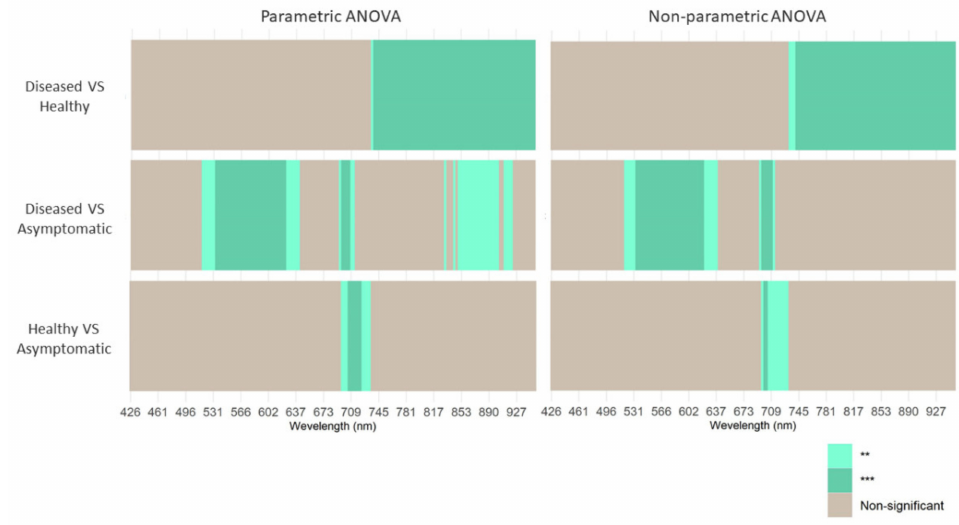
Figure 9. Sensitivity matrix of vegetation spectral discrimination based on the type of statistical test. Parametric versus non-parametric analysis of variance (ANOVA) for the three spectral libraries. p -value < 0.025 (**), p -value < 0.01